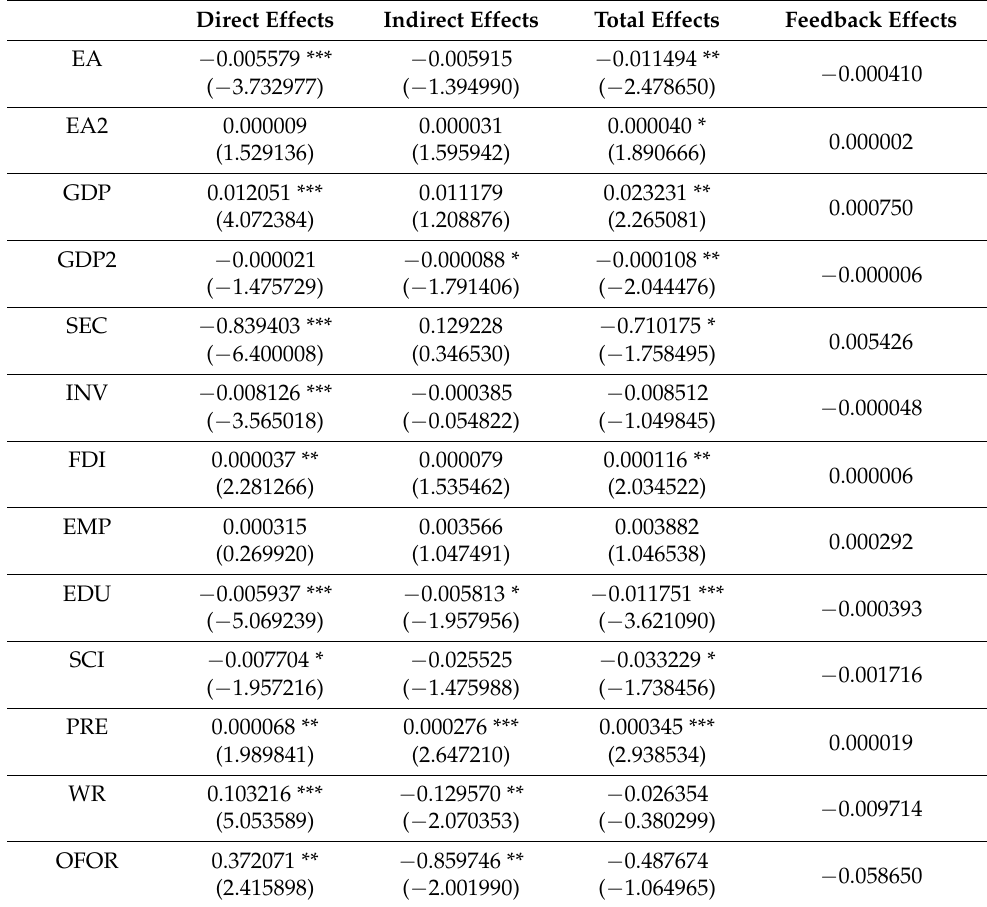
Table 7. Decomposition of effects of SDM with biased